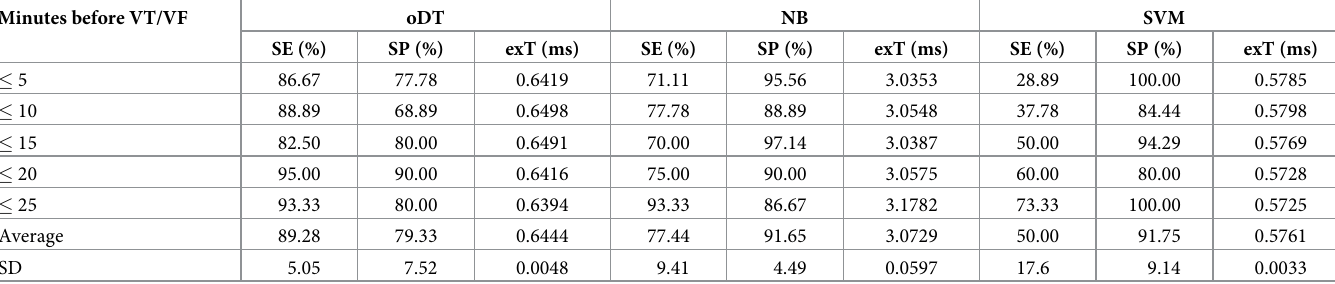
Table 6. Comparison of performance among DT, NB, and